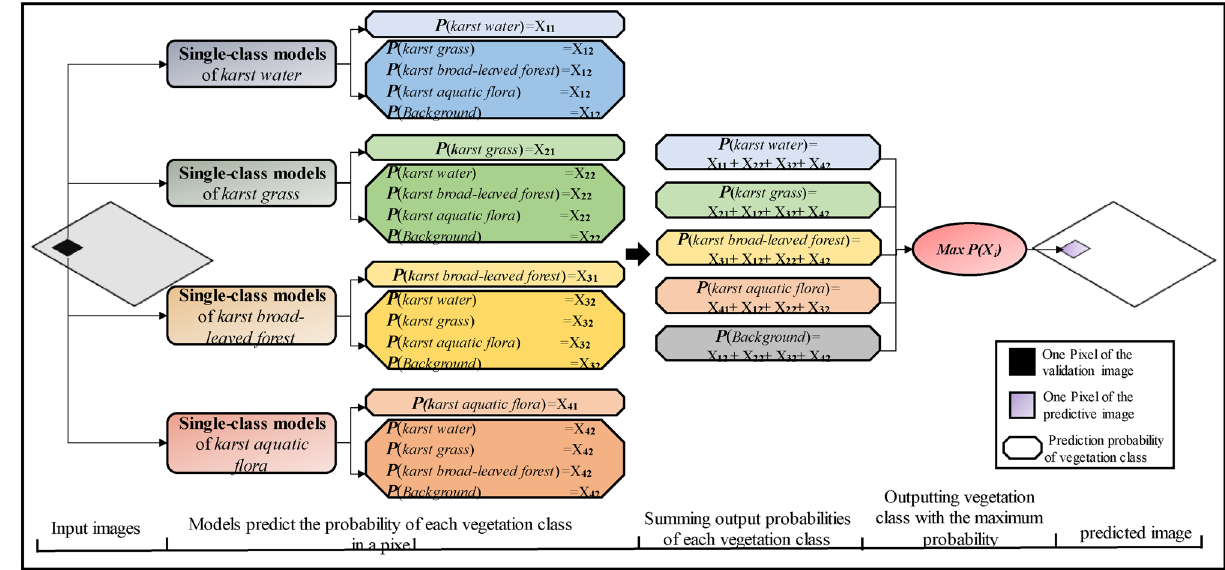
Figure 5. The fusion procedure of multiple single-class SegNet